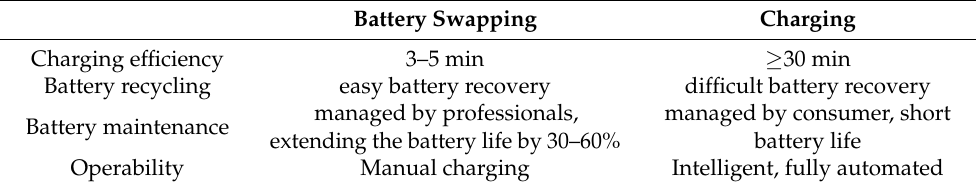
Figure 1. BSS architecture. Table 2. EVs battery swapping technology vs. charging technology.